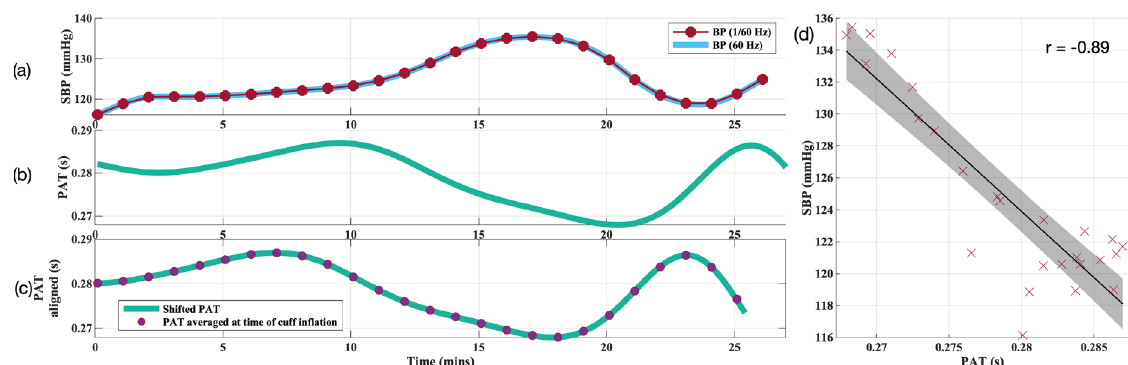
Figure 12. Example of the process for comparing the PAT time series to the SBP time series. ( a ) shows the SBP time series with the cuff inflations at once-a-minute and the 60 Hz interpolated signal used for signal alignment. ( b ) shows the processed PAT time series. ( c ) shows the aligned PAT time series shifted 148.5-s earlier and averaged PAT values at times of cuff inflation. ( d ) shows a scatter plot of the PAT and BP data points and the regression line through